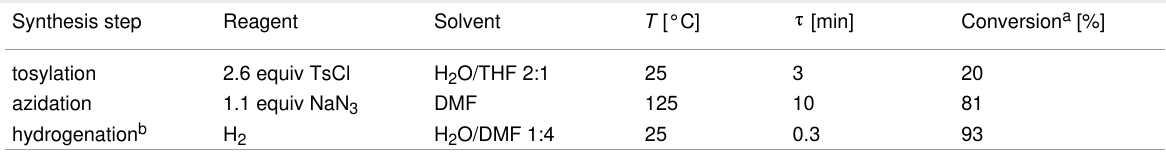
Table 4: Optimal reaction conditions for each flow reaction step.